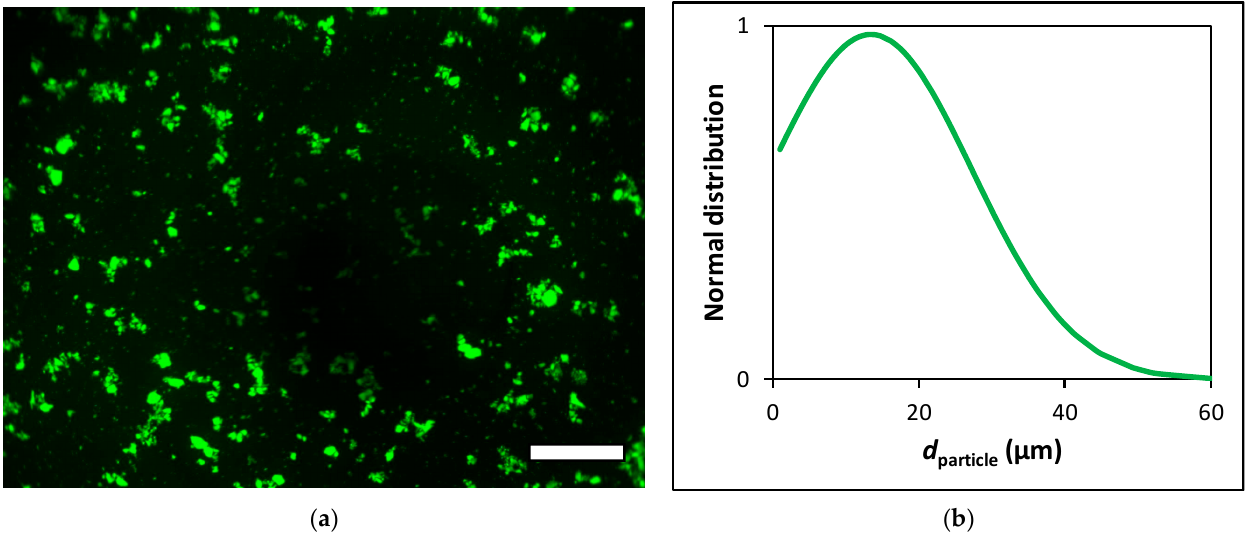
Figure 2. ( a ) Fluorescence microscopy images of the FSGM suspension recorded using FITC fluorescence filter set. Scale bar: 100 µm. ( b ) Size distribution of suspended FSGM determined by image analysis.